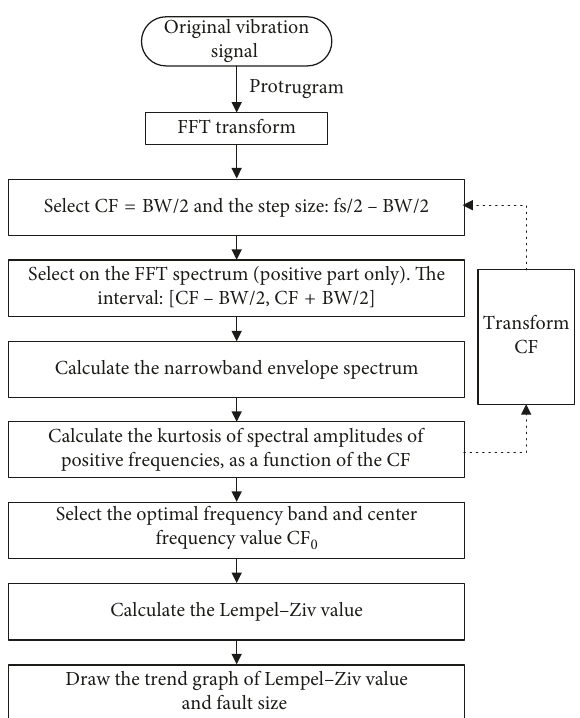
Figure 4: The flowchart of the proposed